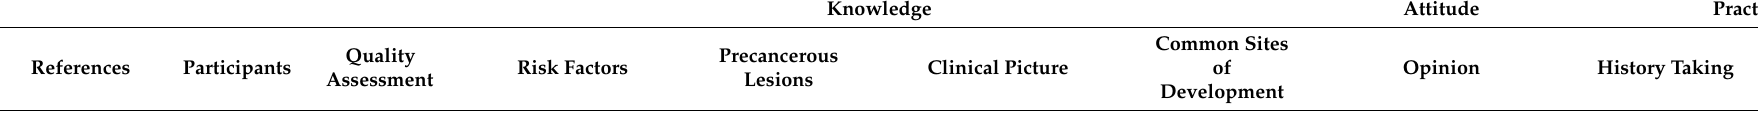
Table 3. Published data about dental practitioners’KAP on